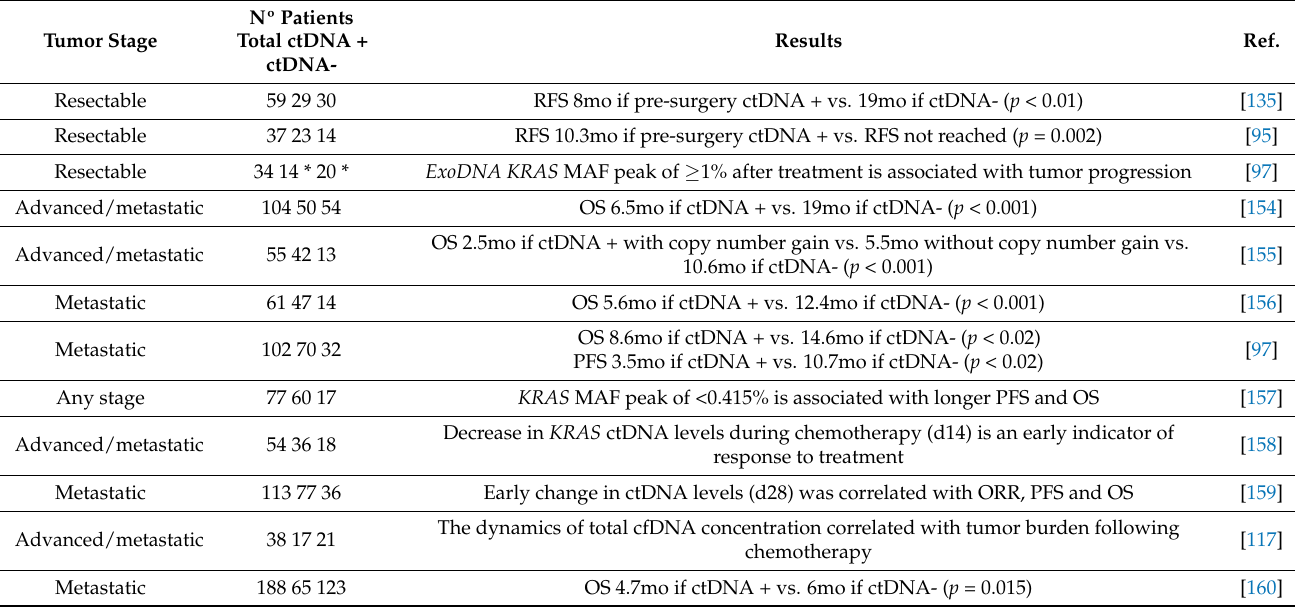
Table 4. Prognostic performance of liquid biopsy in